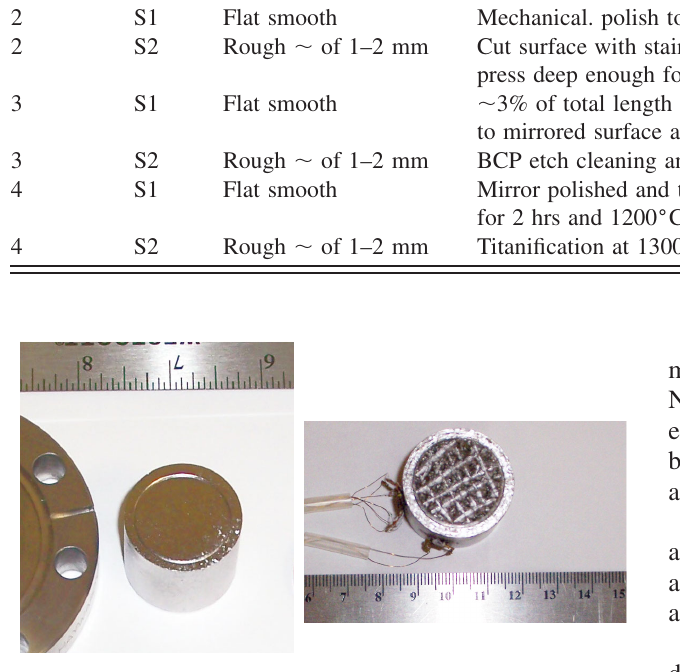
FIG. 3. Two cylindrical samples S1 (left view) and S2 (right view) are shown. The S2 sample has a rough surface ( (cid:3) 1 – 2 mm ) as compared with the smooth surface of sample S1.